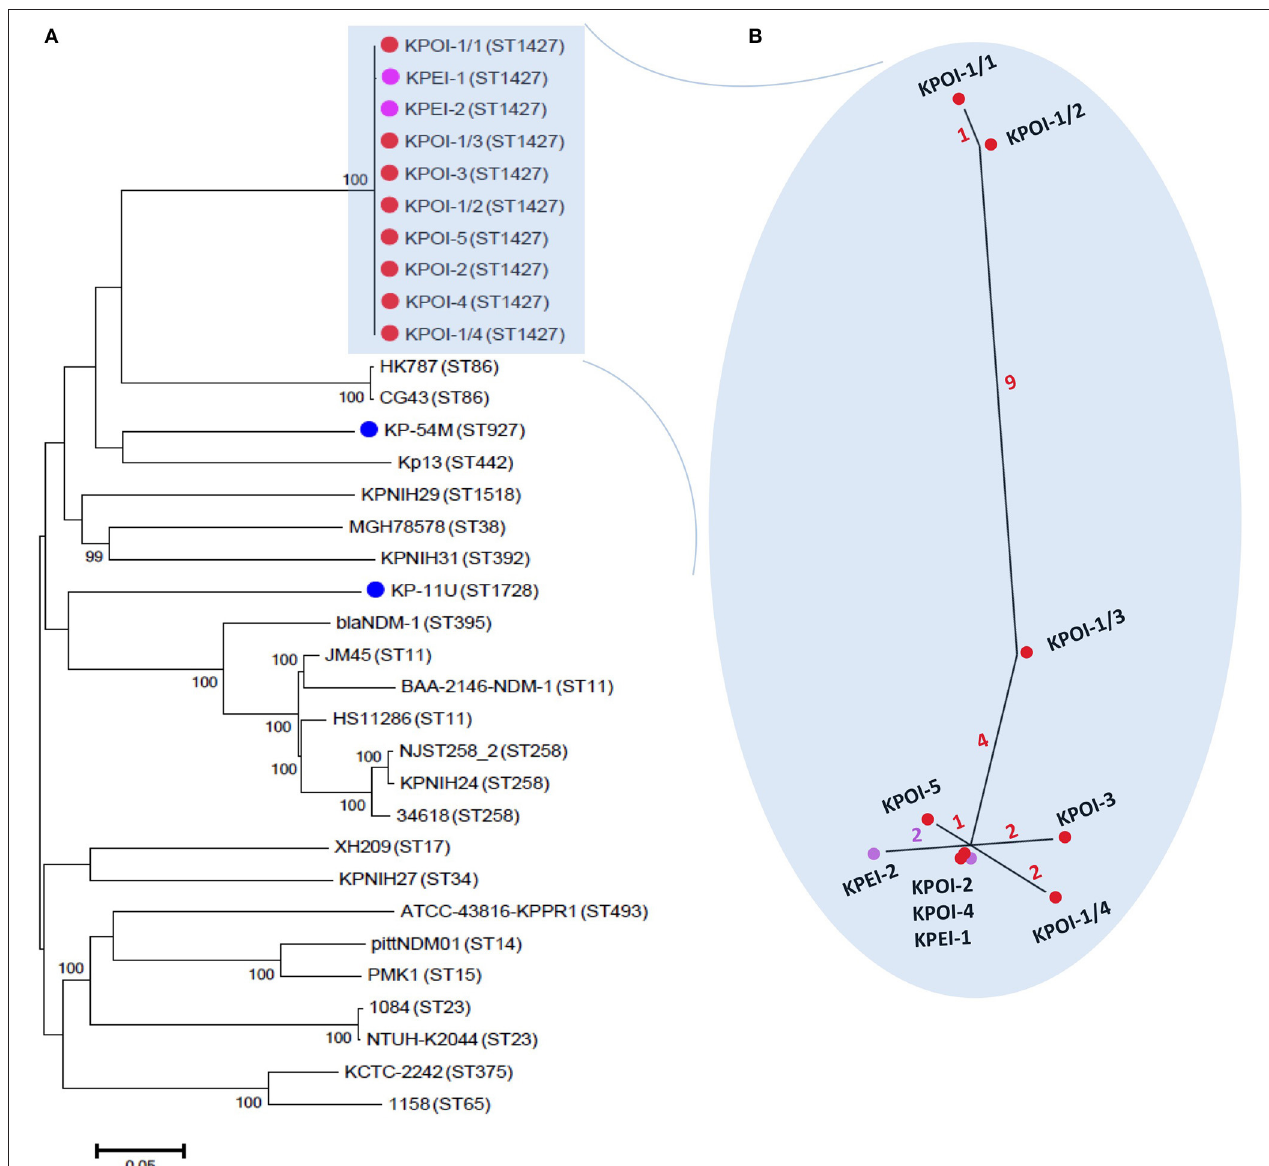
FIGURE 2 | Core-genome phylogenetic analysis of K. pneumoniae . (A) A maximum likelihood tree was constructed based on alignments of 4.4 Mb genomes which were defined as the core genomes in this study. The tree was rooted at the midpoint. The percentage of the supported bootstrap ( > 90) is shown. The isolates sequenced in this study are marked by dots colored red (patients involved in the outbreak), purple (environmental isolates), and blue (unrelated patients). The genomes of unmarked isolates were retrieved from GenBank. Sequence types of isolates are indicated between brackets. (B) The inset shows a close-up of the unrooted maximum likelihood phylogenetic tree of outbreak isolates based on 21 reliable SNPs as described in the text. The number of SNPs is indicated on the branches by different